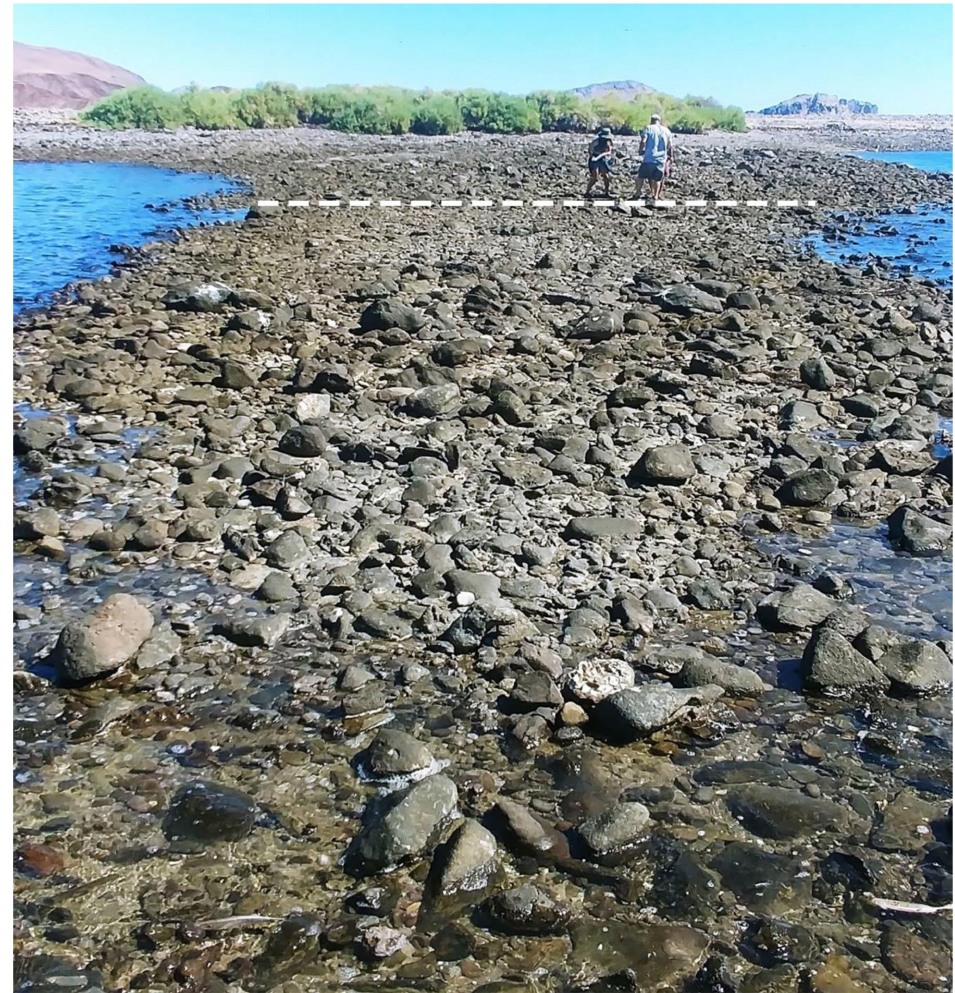
Figure 7. Transect 3 (dashed line) follows a side spur o ff the main spit with a compass orientation 90 ◦